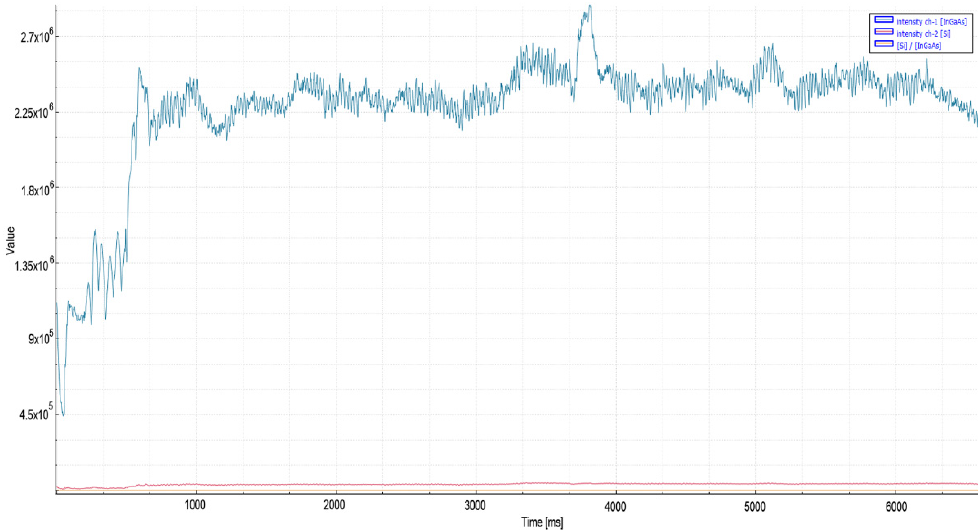
Figure 9. Measurement values recorded during oxygen cutting of 15 mm mild steel material.